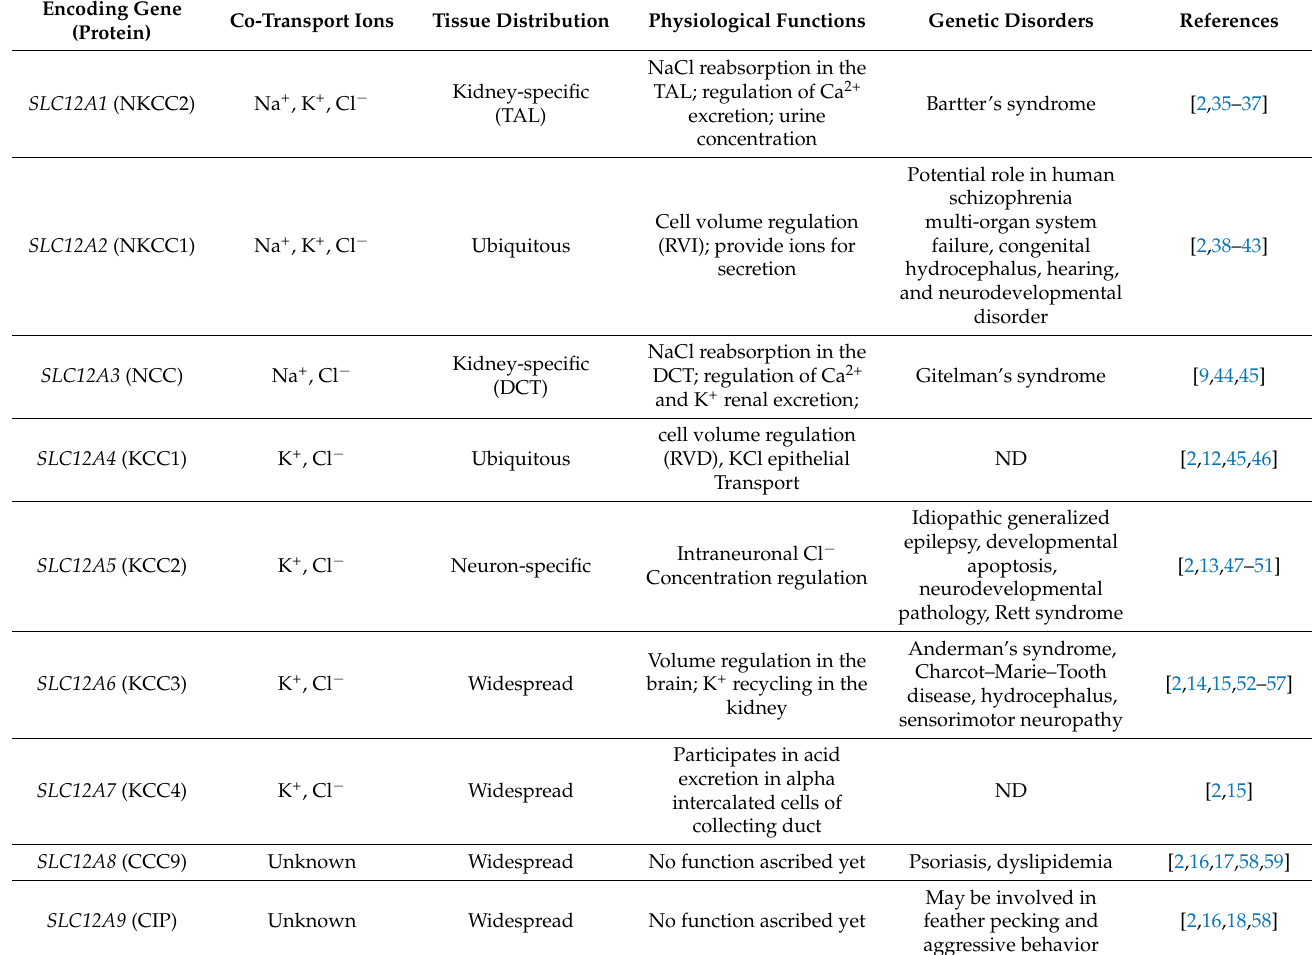
Table 1. The solute carrier family 12 (SLC12) of cation-chloride cotransporters in neurological disorders and others. TAL: thick ascending loop of Henle; DCT: distal convoluted tubule; RVI: regulatory volume increase; RVD: regulatory volume decrease; ND: no data (or none). Functional regulation of the cation-chloride cotransporter family. Encoding Gene